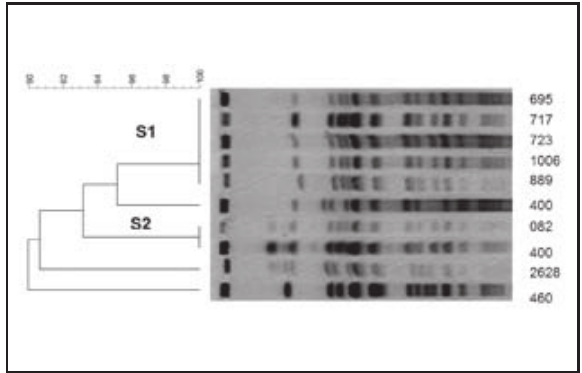
DNA genômico com XbaI